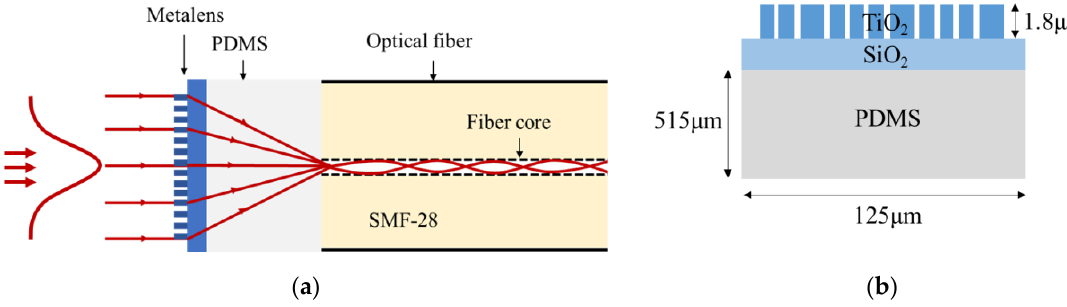
Figure 1. ( a ) The optical layout of the single-mode fiber and the this designed metasurface fiber coupler; ( b ) The structure of this designed metalens fiber coupler: (1) the supported PDMS layer, (2) the SiO 2 layer, (3) the metasurface TiO 2 layer.